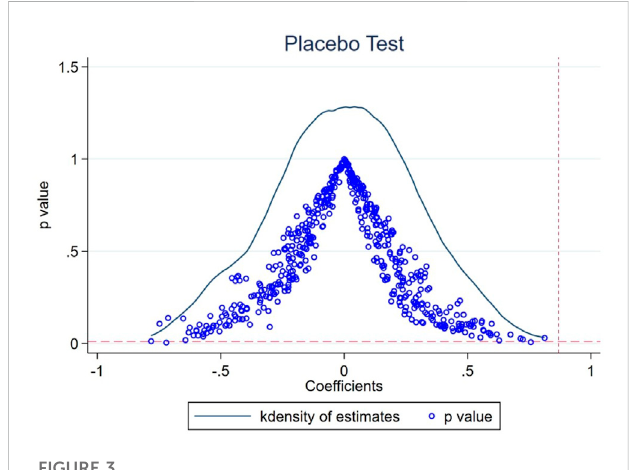
FIGURE 3 Placebo test results. Notes: The estimated coef fi cients are the upper and lower limits of the 95% con fi dence interval.